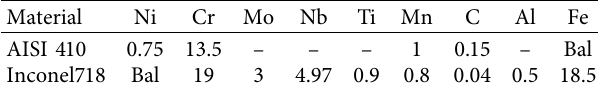
Table 1: Chemical composition of Inconel 718 and AISI410 (wt %).